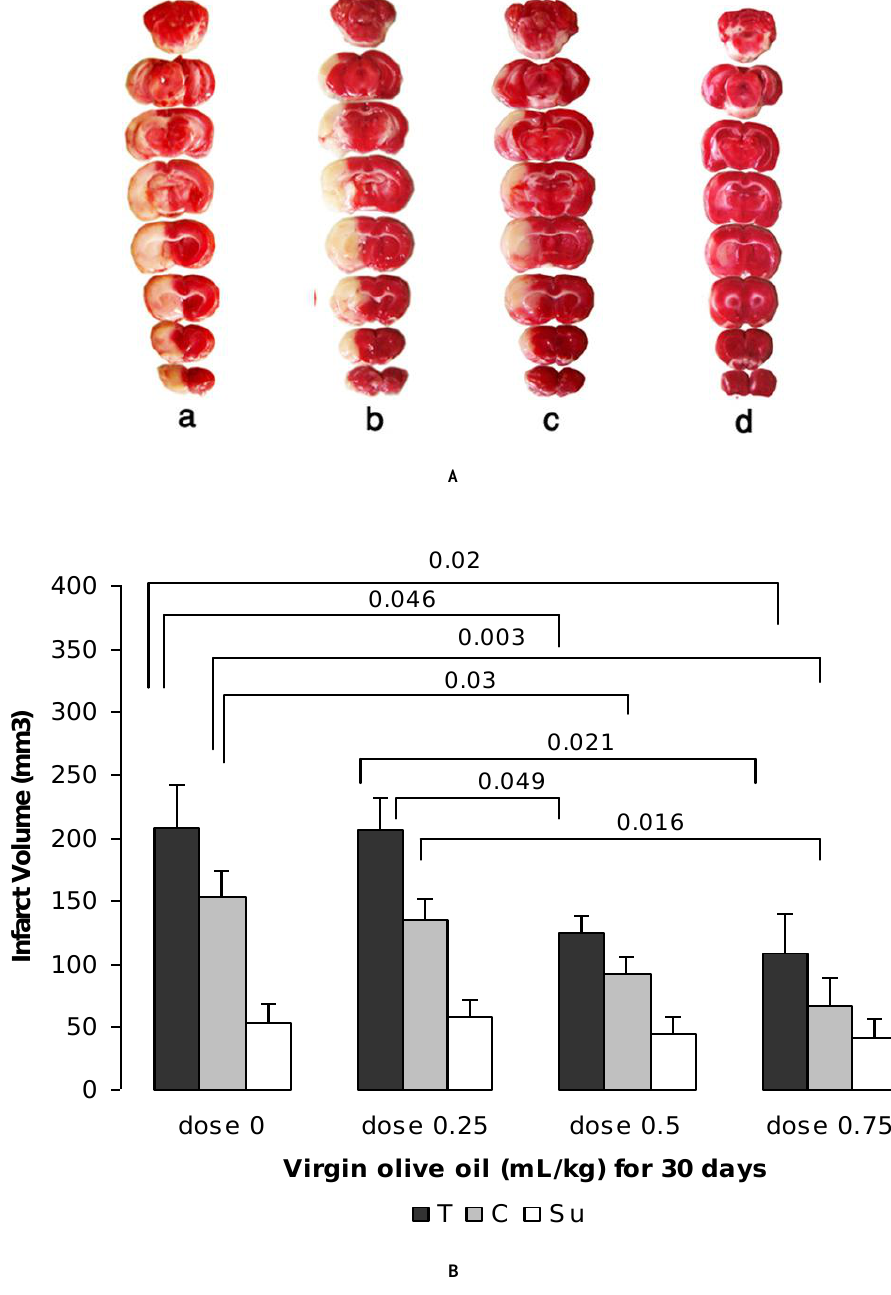
FIGURE 3. (A) Photograph showing the neuroprotective effect of VOO on focal cerebral ischemia. All sections of the brain were stained with TTC at 24 h after 60 min of ischemia. Each column presents the series of rat brain coronal sections: (a) brain sections of control rat; (b,c,d) brain sections of 0.25, 0.5, and 0.75 mL/kg/day pretreated rats, respectively. (B) The graph shows the effects of various doses (0, 0.25, 0.5, and 0.75 mL/kg) of VOO on infarct volume in different experimental groups in cortex (C), subcortex (Su), and total (T) area of brain (each group n =